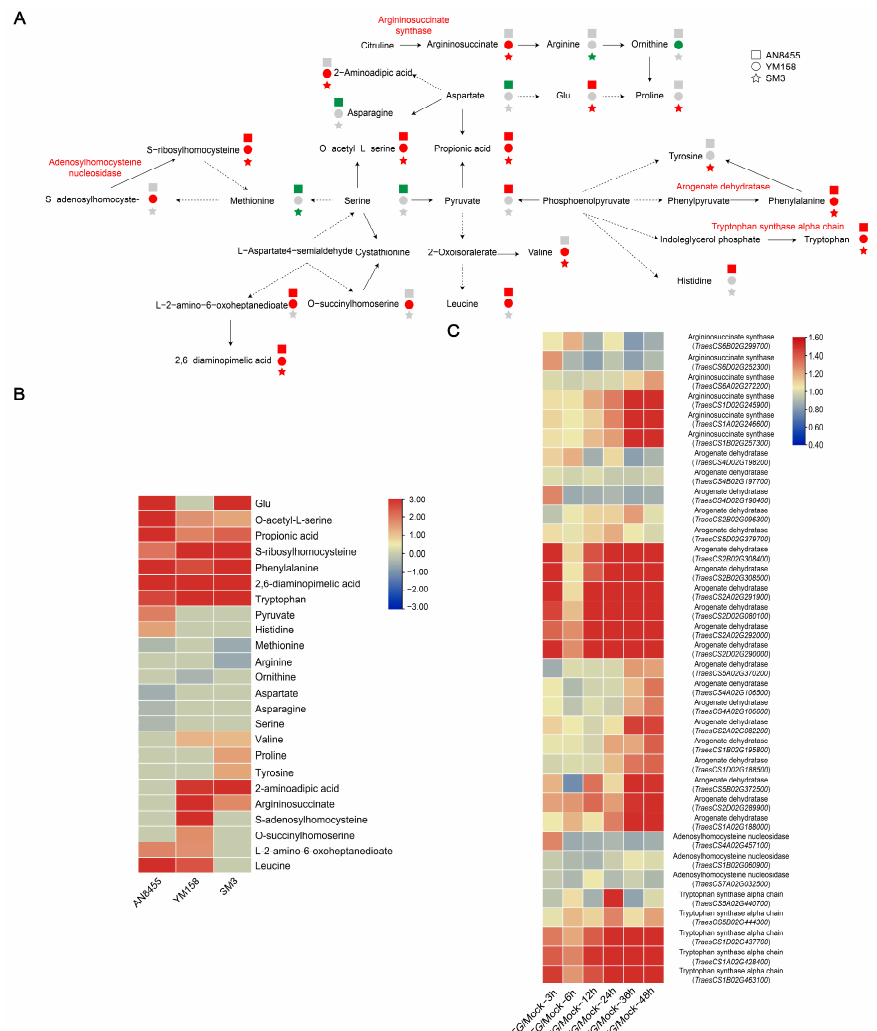
Figure 5. Amino acid and derivatives. ( A ) Schematic diagram of amino acid biosynthesis. The squares, circles, and stars represent AN8455, YM158, and SM3, respectively. Red, green, and gray shapes represent upregulated expression, no obvious change, and downregulated expression, respectively. ( B ) Radio value ( Fg vs. Mock) of amino acid and derivatives. ( C ) Gene expression heatmap of enzymes involved in amino acid biosynthesis, sourcing from WheatGene (http://wheatgene.agrinome.org/ (accessed on 9 July 2022)).